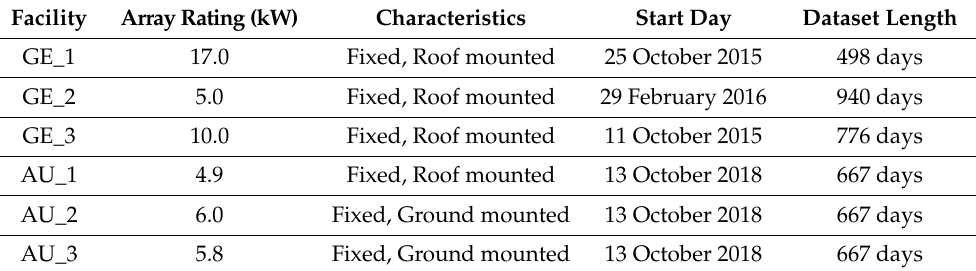
Table 1. Main characteristics of the PV facilities and datasets.